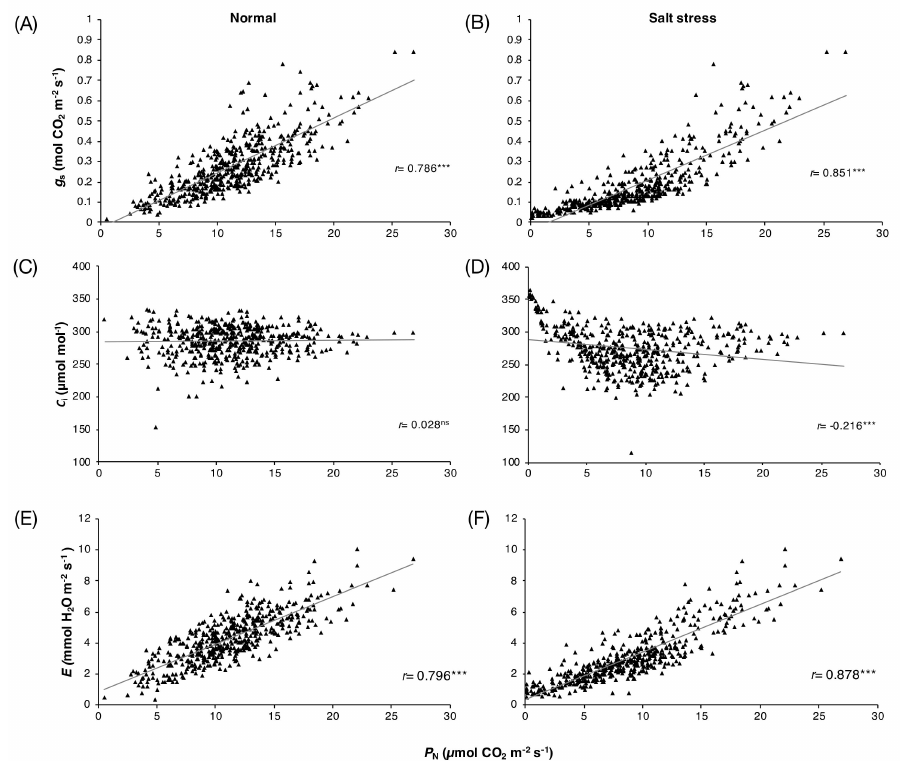
Figure 1. Correlations among photosynthetic parameters of 30 rice varieties grown under normal and salt stress conditions for 0, 3, 6, and 9 days: P N and g s ( A , B ), P N and C i ( C , D ) and P N and E ( E , F